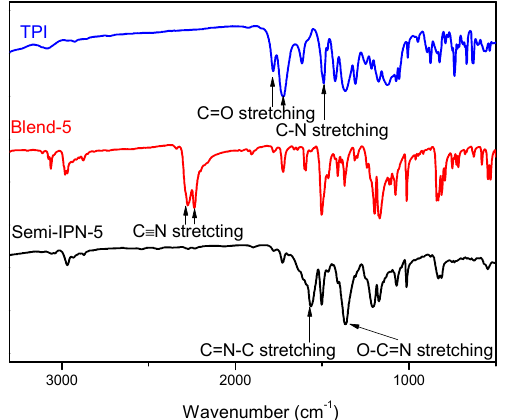
Figure 1. Representative FT-IR spectra of TPI, TPI / BADCy blend, and semi-interpenetrating polymer network (semi-IPN).